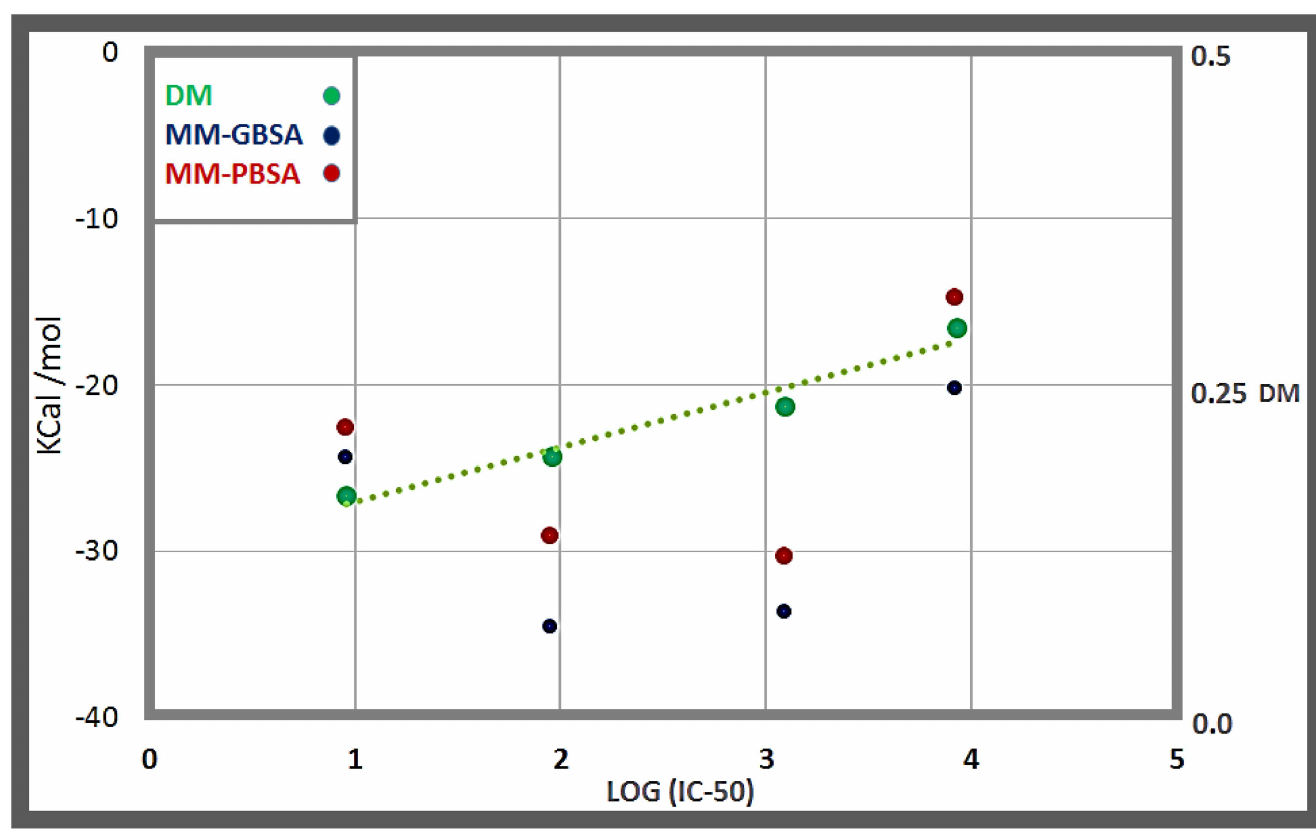
Fig 3. Correlation of the DM value with IC50 for different molecules that bind MDM2: compound 14-b [22], nutlin-3a [20], compound 1-a [23] and compound DING-1a [24], whose IC-50 are 9.2, 90, 1230 and 8400 nM, respectively. We also include the values of bindingenergy calculated by the MM-PBSA and MM-GBSA